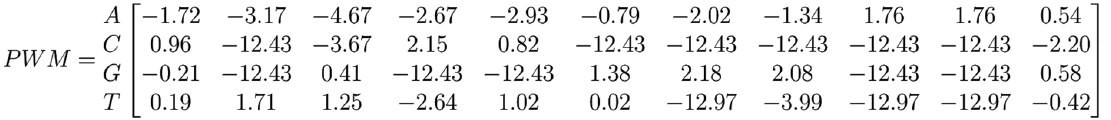
Figure 2. Calculated position weight matrix (PWM) by means of Equation 2.